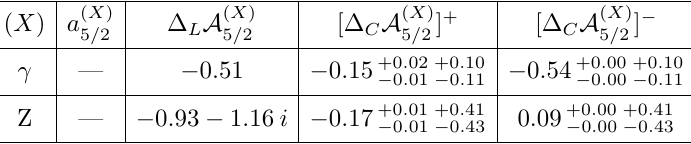
. The two uncertainties in the local 5 = 2